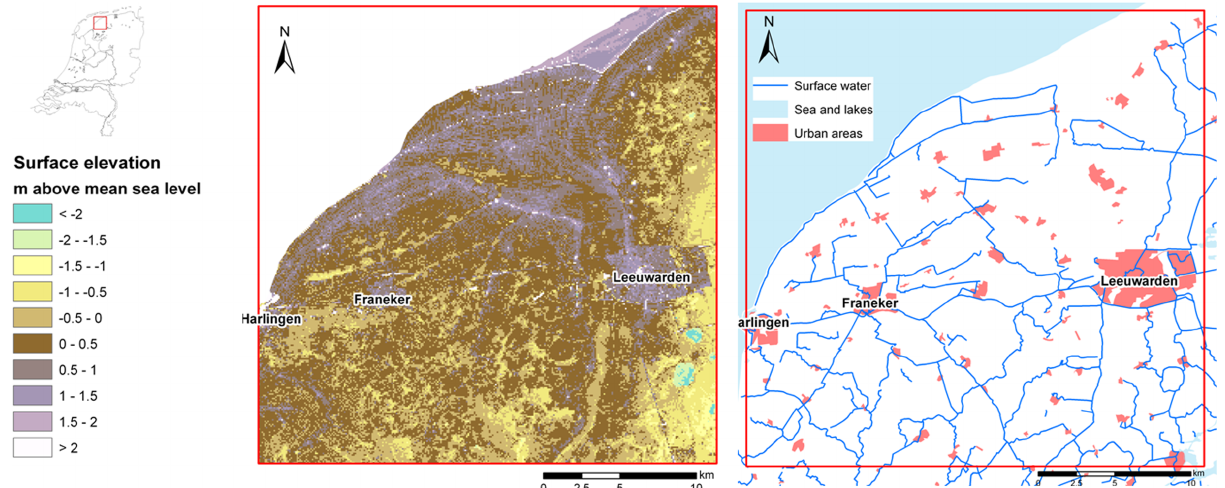
Fig. 1. The position of the study area within the Netherlands showing the surface elevation (left panel), and a topographic map showing the surface water, the urban areas and the Wadden Sea (right